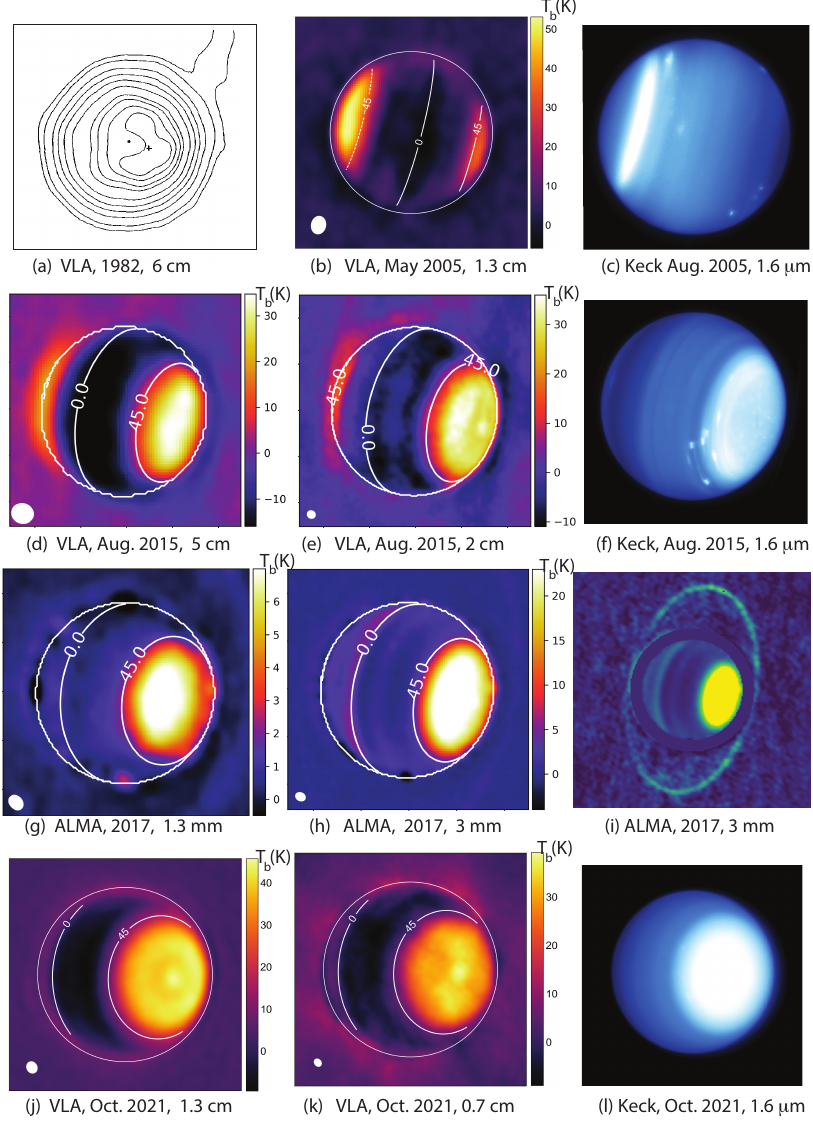
Figure 17. Radio images of Uranus taken in different years and at different wavelengths. The color bars indicate the brightness temperature residuals in Kelvin; for those maps, a uniform limb-darkened disk had been subtracted from the data. The synthesized beam of those images is shown as a white ellipse in the bottom left corner of each image. ( a , e ) Observations in 1982 at 6 cm, when the south pole (indicated by a +) was near the subsolar point (the dot) [134]. ( b ) Observations in 2005 at 1.3 cm (Courtesy: M. Hofstadter & B. Butler). The planet is roughly 3.5–4” across. ( c ) Image in the near-IR taken with the Keck telescope close in time to image b. ( d , e ) VLA maps from 2015 [57]. ( f ) Image in the near-IR taken with the Keck telescope in August 2015. ( g , h , i ) ALMA maps from 2017. The map in panel i shows the first radio detection of Uranus’s rings [57,141]. ( j , k ) VLA maps from October 2021 [14,15]. ( l ) Keck image in the infrared from October